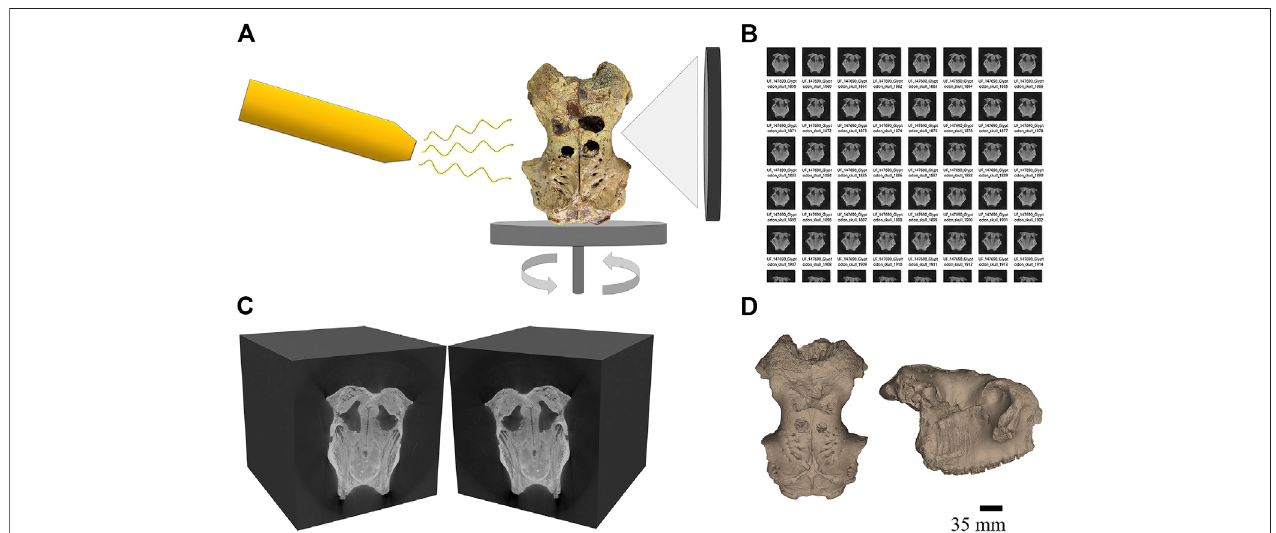
FIGURE 1 | Basic CT scanning work fl ow of a Glyptodon sp. skull (UF-VP-147690) where the black scale bar indicates 35 mm (A) X-rays are penetrating the fossil asitrotatesonaplateplatformindorsalview,anteriorup.Imagesarecaptured onthedetector plateoppositetotheX-raysourcewitheach rotationoftheplate (B) A fi le folder is produced with hundreds/thousands of tomograms taken from all sides of the specimen and are typically called a TIFF stack because they are composed of. tiff image fi les (C) Using computer software, the. tiff images can be stacked together and sliced on x , y , or z planes. Here the TIFF stack is sliced in the x plane around themiddleofthespecimen (D) Usingadditionalcomputersoftware,theTIFFstackscanbemanipulatedtovirtuallyextractthespecimenorspeci fi cpartsofit.Here,a3D model of the fossil specimen is featured and oriented where: left) dorsal view, anterior up and right) lateral view, anterior right.